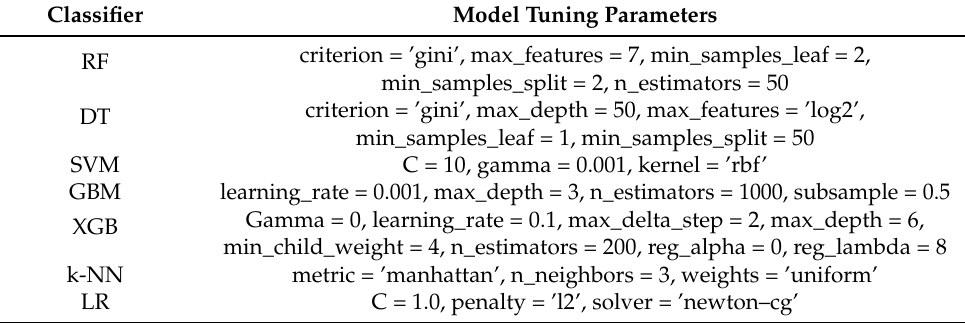
Table 4. Model Hyperparameter